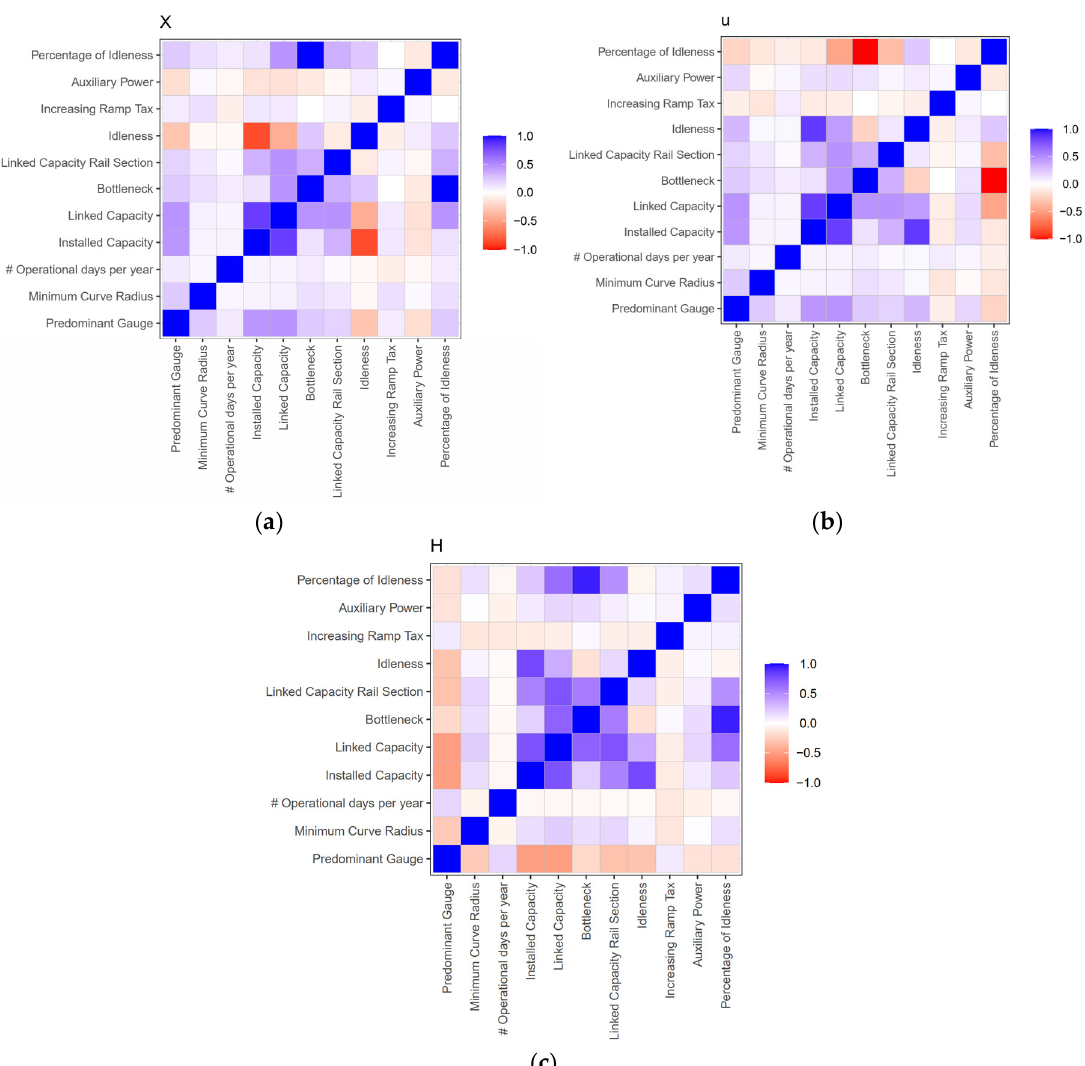
Figure 4. ( a ) (top-left) presents the correlograms for the normalized attributes. ( b ) (top-right) pre- sents attributes’ distances to ideal solutions. ( c ) (bottom) presents attributes’ hesitant membership function value.